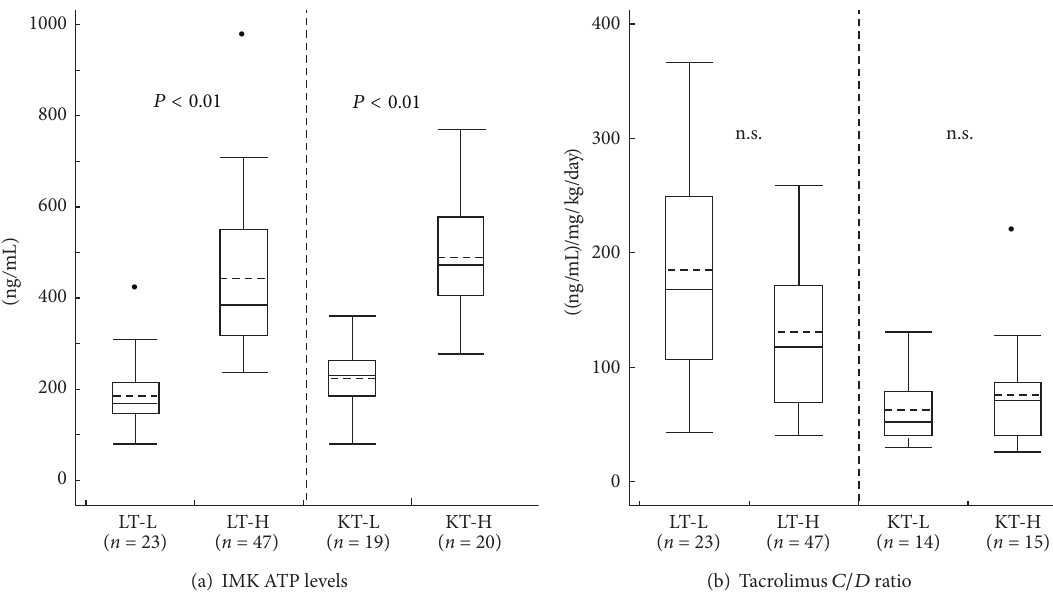
Figure 3: IMK ATP levels and tacrolimus 𝐶/𝐷 ratio in LT and KT patients. (a) The mean ATP levels in LT-L patients was significantly lower than that in LT-H (185.7 (82–310) ng/mL versus 442.7 (238–966), 𝑃 < 0.01 ), and KT-L patients had also lower IMK ATP levels than KT-H patients (225.6 (80–359) ng/mL versus 488.6 (277–770), 𝑃 < 0.01 ). (b) The mean tacrolimus 𝐶/𝐷 ratios were 184.5 (43–366) ng/mL per